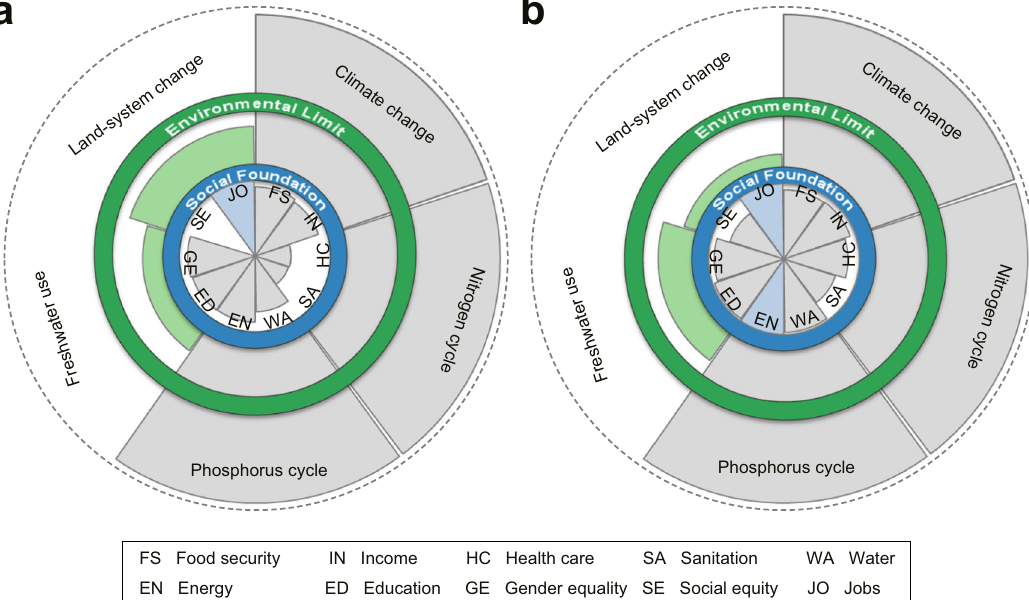
Fig. 3 | The performance relative to the safe and just operating space from 2000 to 2018. a The world. b China. When internal wedge reaches the social foundation and external wedge is within the environmental limit, the state is con- sidered a safe and just operating space. Internal wedges indicate actual social indicators relative to the social foundations. External wedges show environmental footprints relative to the environmental limits. Values depict the average of the